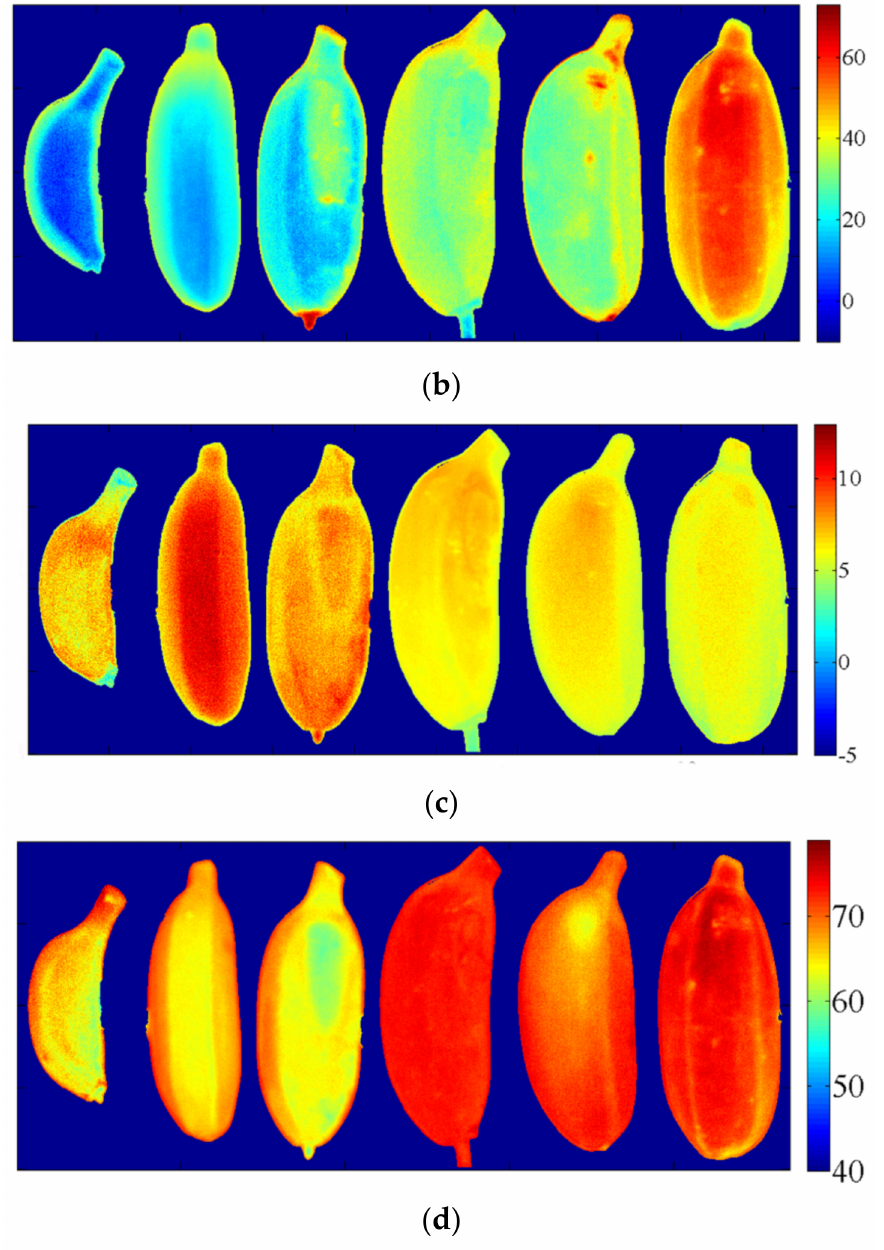
Figure 8. Distribution maps visualizing different quality parameters: ( a ) SSC; ( b ) TA; ( c ) chlorophyll and ( d ) ∆ E*. The number on the color bar represents the concentration values of SSC, TA, *E* and chlorophyll. The color from blue or cyan to red indicates an increase of